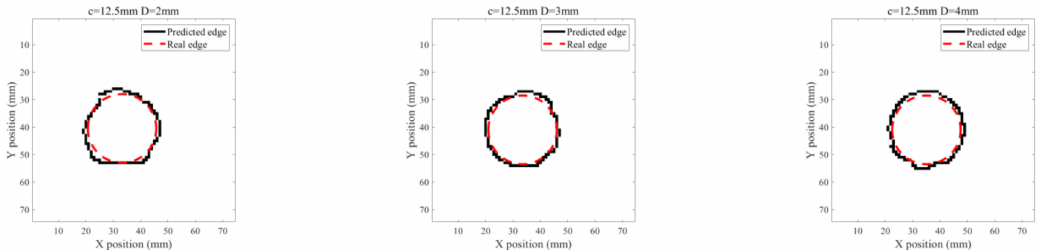
Figure 10. Edge-identification results for ILC Scenario #1.